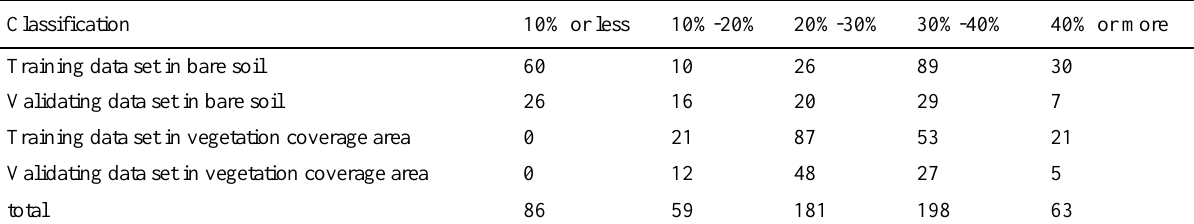
Table 1. The training data set and validating data set